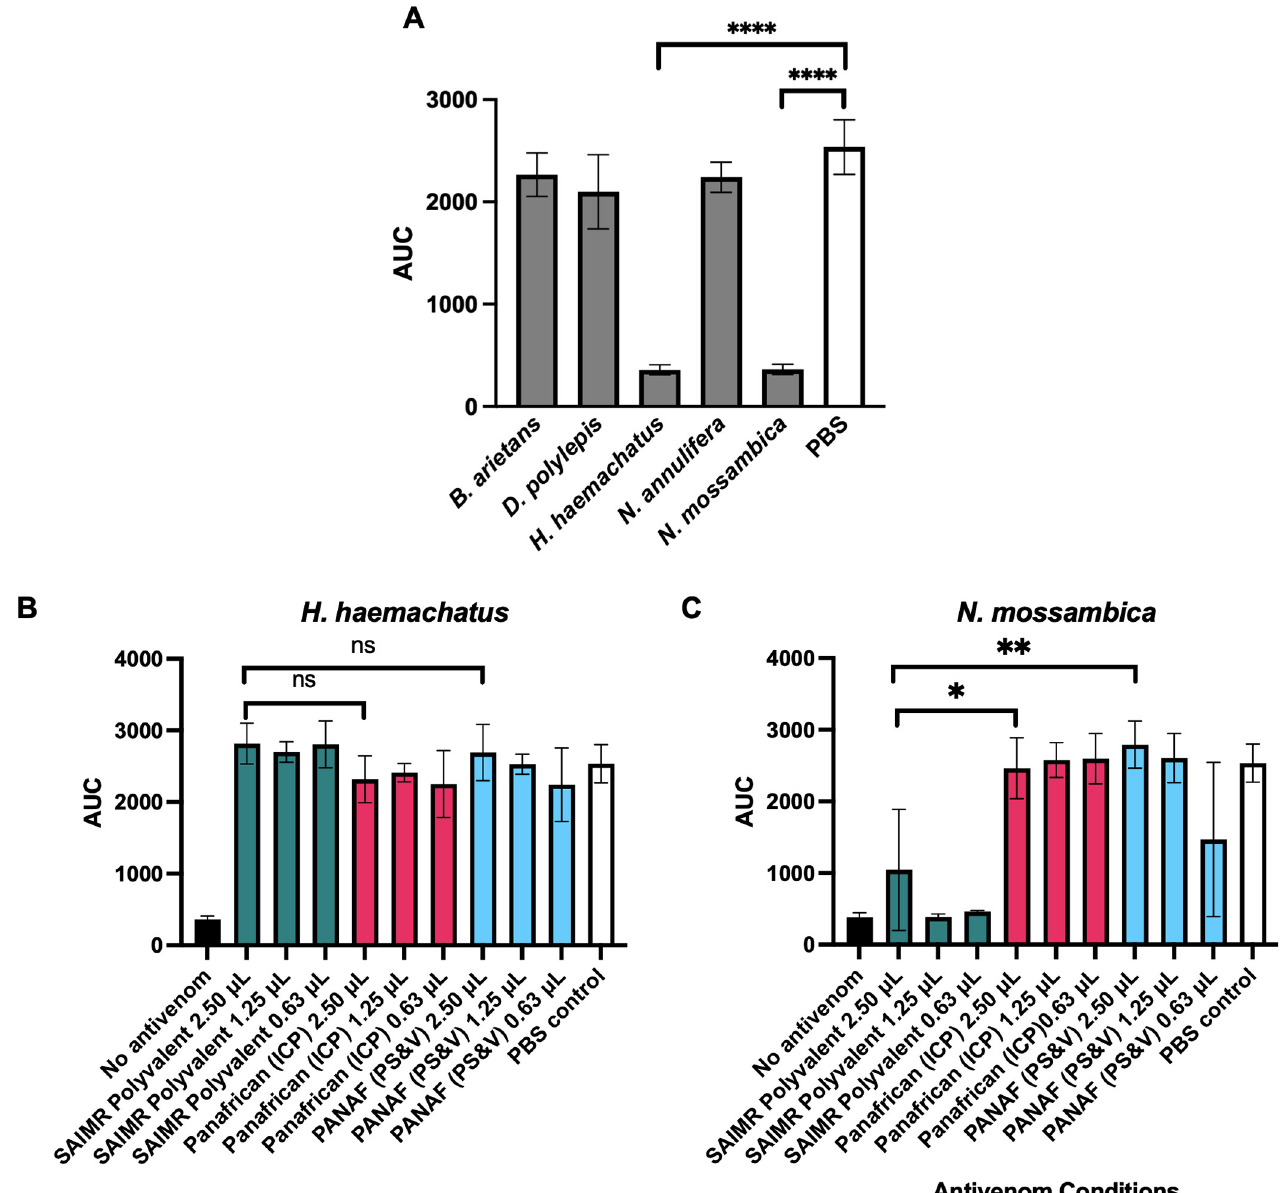
Fig 4. Plasma clotting activity of Eswatini venoms and their neutralisation by three antivenoms. Data show the mean area under the curve of nine replicates and error bars represent standard deviation. ���� indicates p < 0.0001, �� indicates p < 0.01 and � indicates p < 0.05 by one-way ANOVA. A: Plasma clotting activity of B . arietans , D . polylepis , H . haemachatus , N . annulifera and N . mossambica in comparison to PBS normal clotting control (white bar). B: Effects of antivenoms on neutralising the anticoagulant effects of H . haemachatus venom. C: Effects of antivenoms on neutralising the anticoagulant effects of N . mossambica venom. Normal clotting is shown by ‘PBS control’ bars in white (wells contain no venom), and venom-induced clotting deficiency shown by ‘no antivenom control’ bars in black.